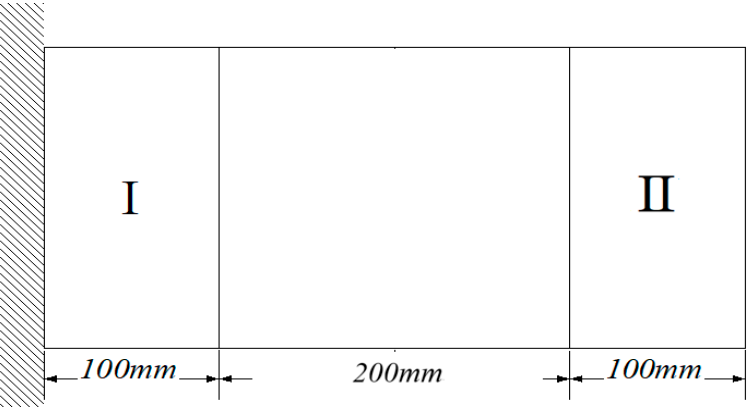
Figure 11. Two models of piezoelectric patch position.